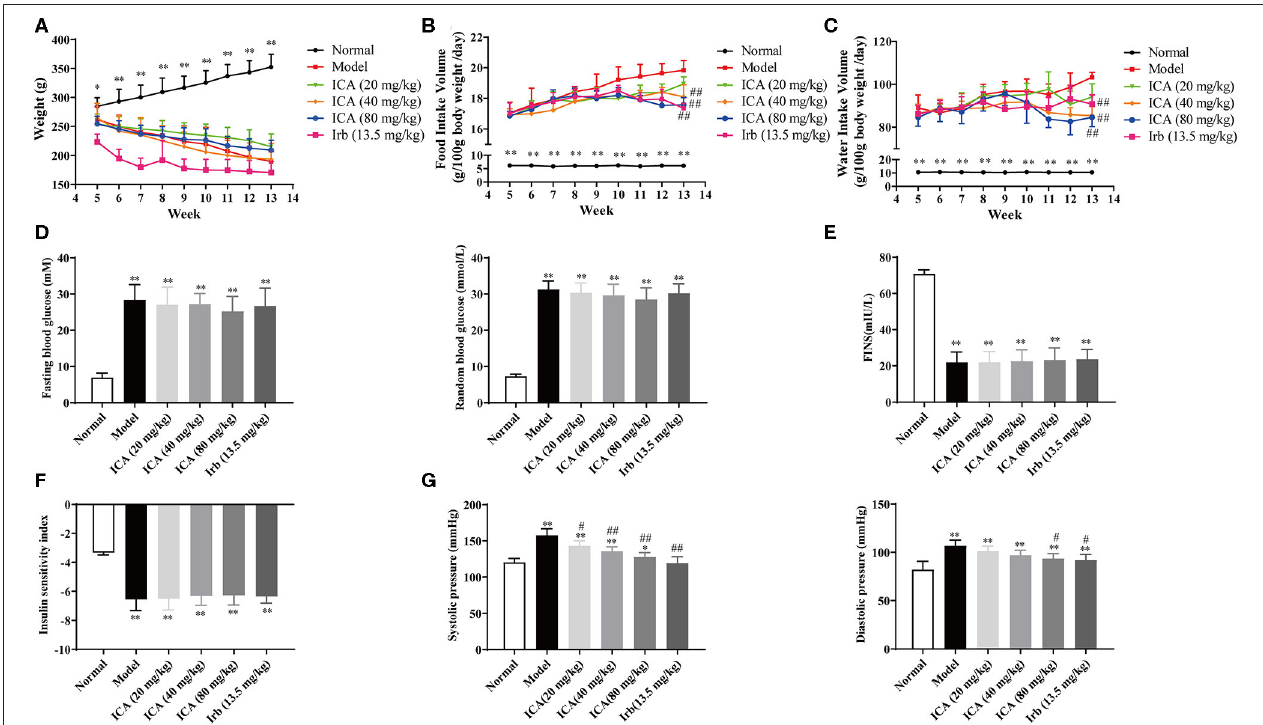
FIGURE 3 | Icariin prevented the development of diabetes in STZ-induced diabetic rats. Rats were subjected to diabetic nephropathy, and orally administered with icariin (20, 40, 80 mg/kg) or irbesartan (13.5 mg/kg) daily for 9 weeks. Rats were sacrificed, and kidneys were isolated. (A) Body weight. (B) Food intake. (C) Water intake. (D) Blood glucose. (E) Fasting serum insulin. (F) Insulin sensitivity index. (G) Blood pressure. Data are expressed as mean ± SD. * p < 0.05, ** p < 0.01, compared with the normal control group; # p < 0.05, ## p < 0.01, compared with the Model group ( n = 10).